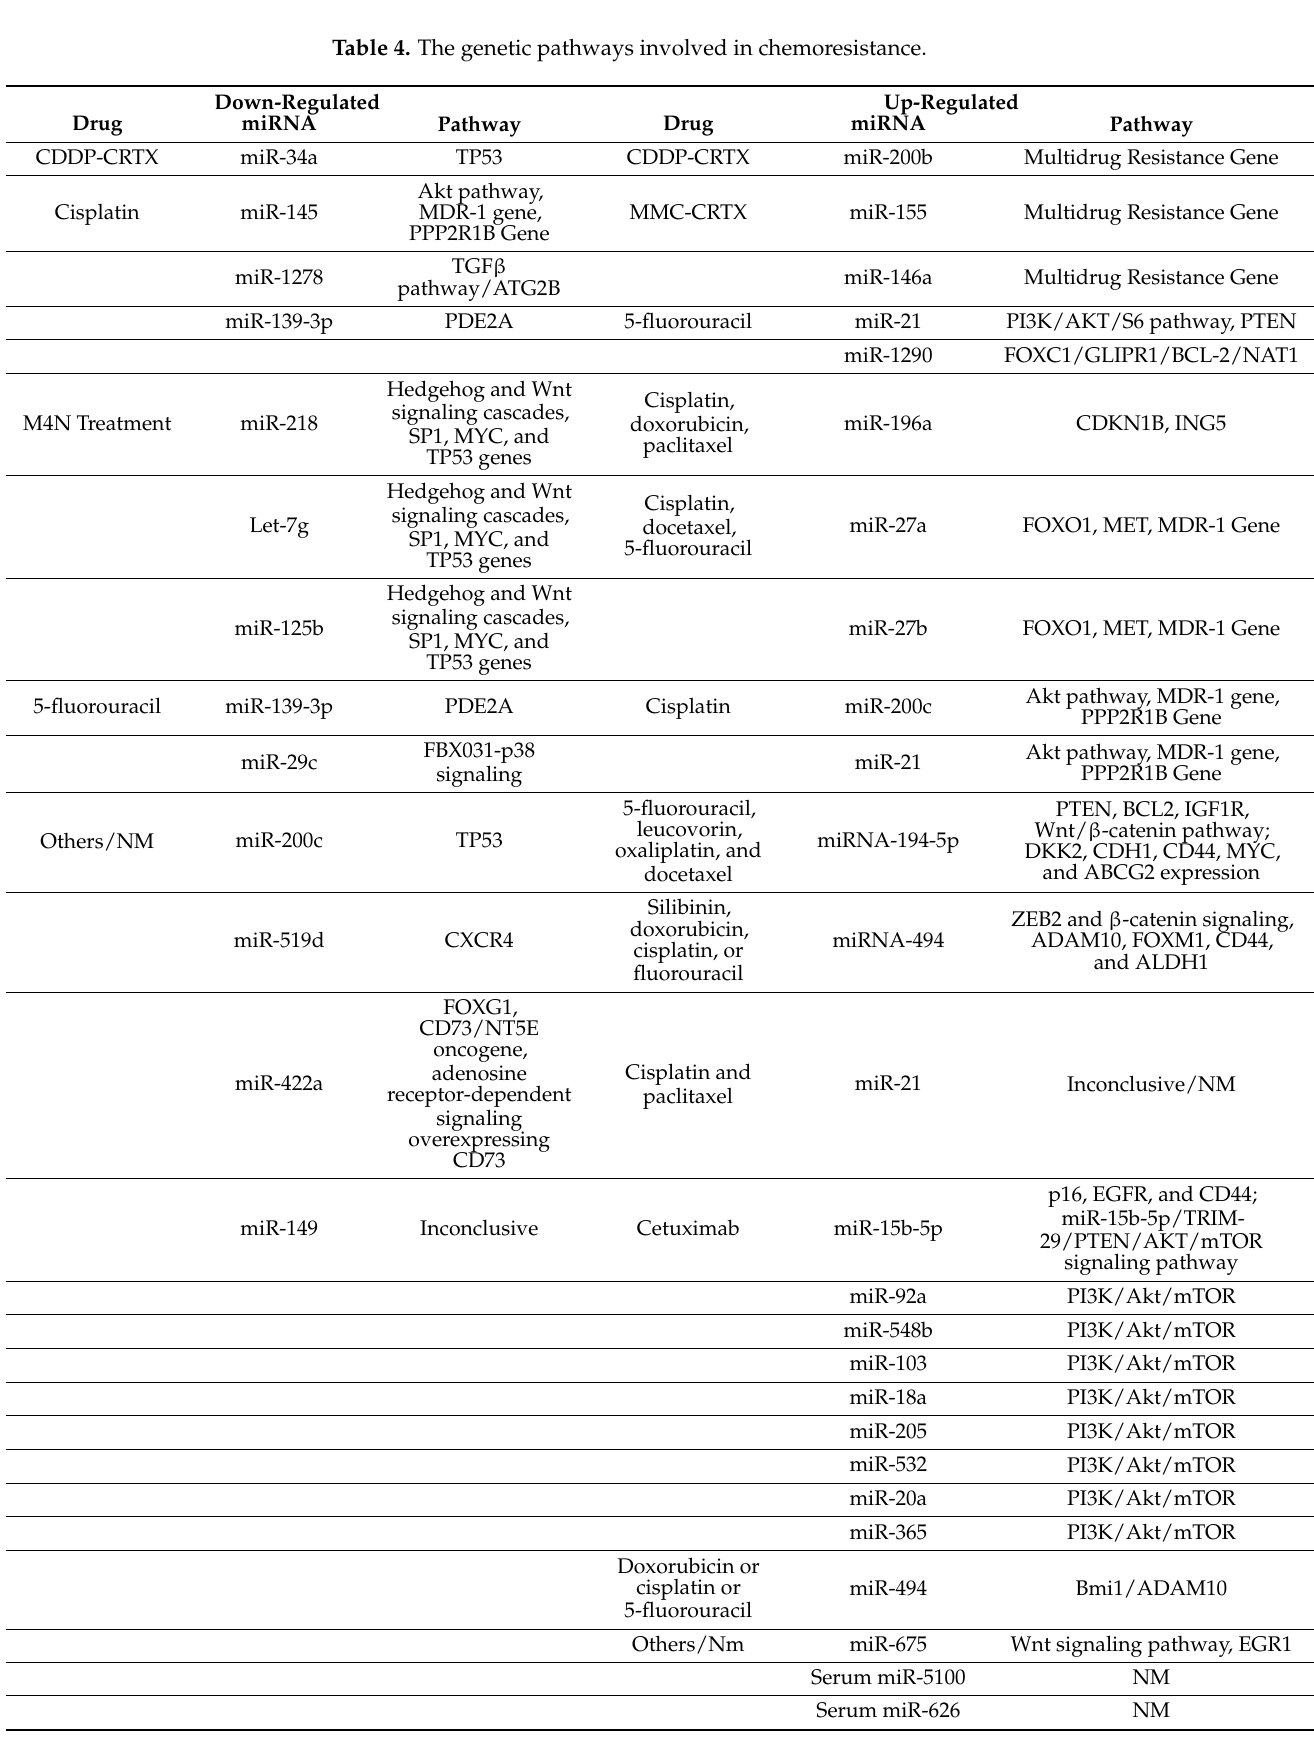
Table 4. The genetic pathways involved in